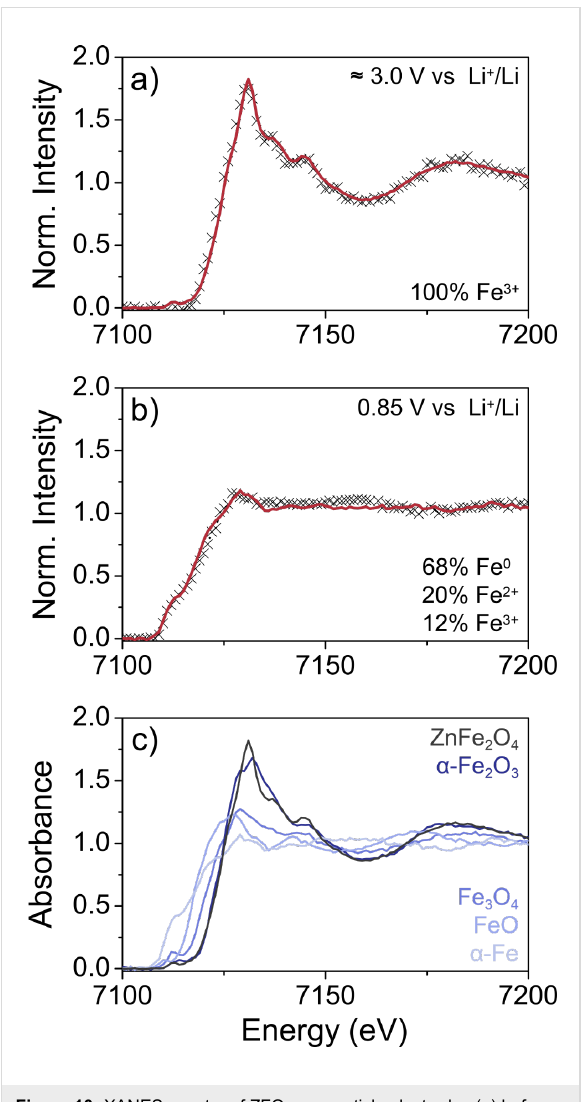
Figure 10: XANES spectra of ZFO nanoparticle electrodes (a) before cycling and (b) in a lithiated state and corresponding least-squares linear combination fits (red lines). (c) XANES reference spectra used for fitting.